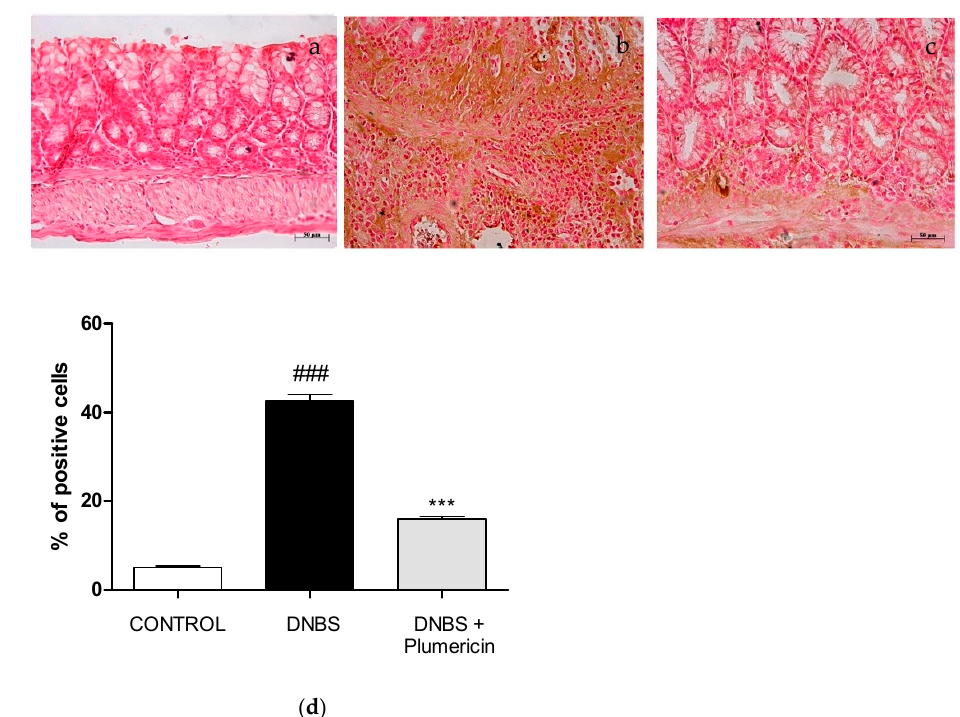
Figure 7. Effects of plumericin treatment on PAR formation ( a – c ) in colitis induced by DNBS. These data are also visible in graph of the percentage of total tissue area ( d ). Photographs are representative of all animals in each group. Data are expressed as the mean ± S.E.M. of 10 mice for each group. ### denotes p < 0.001 vs. control; *** denotes p < 0.001 vs. DNBS.